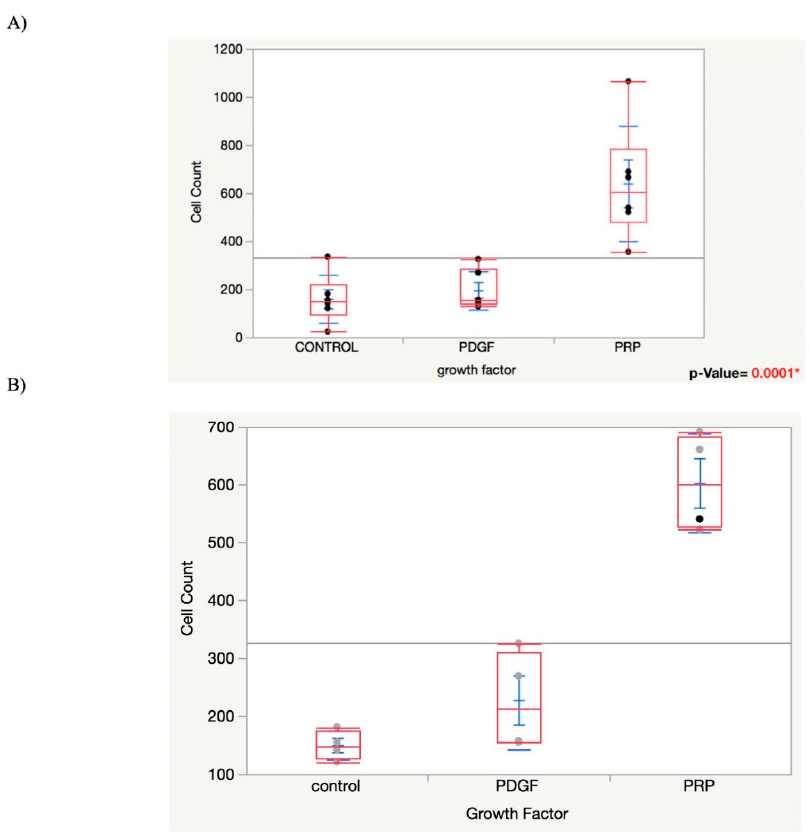
Figure 3. ( A ) Graph showing one-way ANOVA analysis for the migration assay “Cell Count” by “Growth Factor” among the groups. ( B ) Graph showing one-way ANOVA analysis for migration assay after removing the outliers. p -value < 0.0001*.